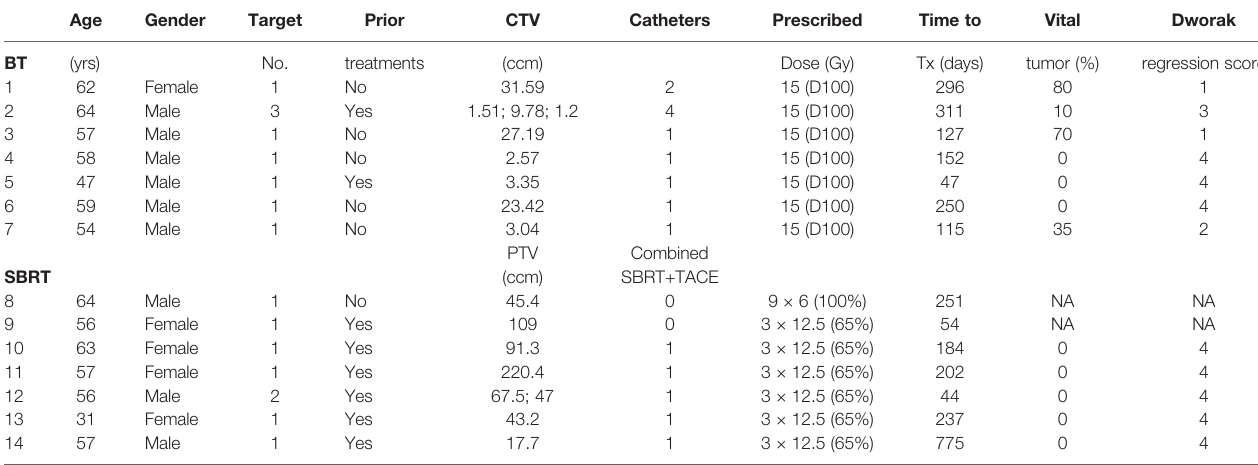
TABLE 2 | Dose prescription and histological classi fi